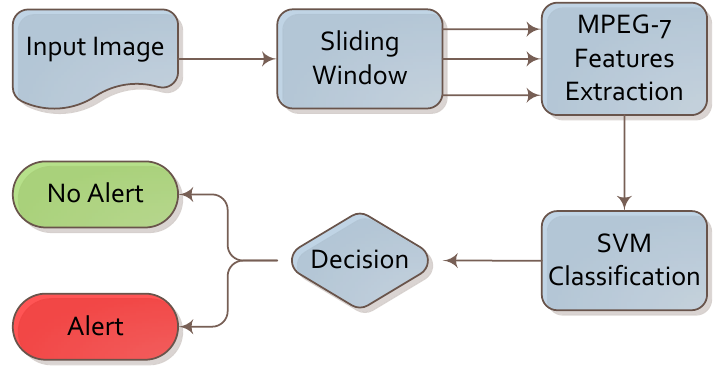
Figure 1. Algorithm for knife detection.